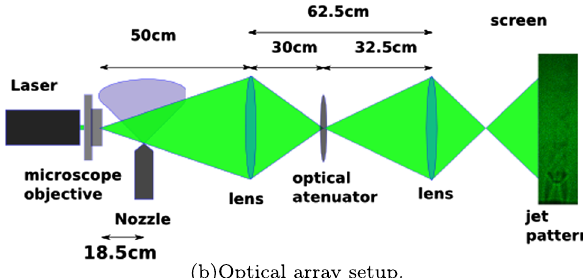
FIG. 7. (a) Schlieren photographic images obtained using a circular nozzle. Each vertical strip corresponds to the pattern observed when air is forced upwards into the atmospheric pressure of the laboratory. The corresponding value of the injection pressure for each photograph is labeled in the bottom (atm units). (b) Optical array: in this case a simple rectangular aperture was used. The flow goes from an air bottle at high pressure into the atmosphere.